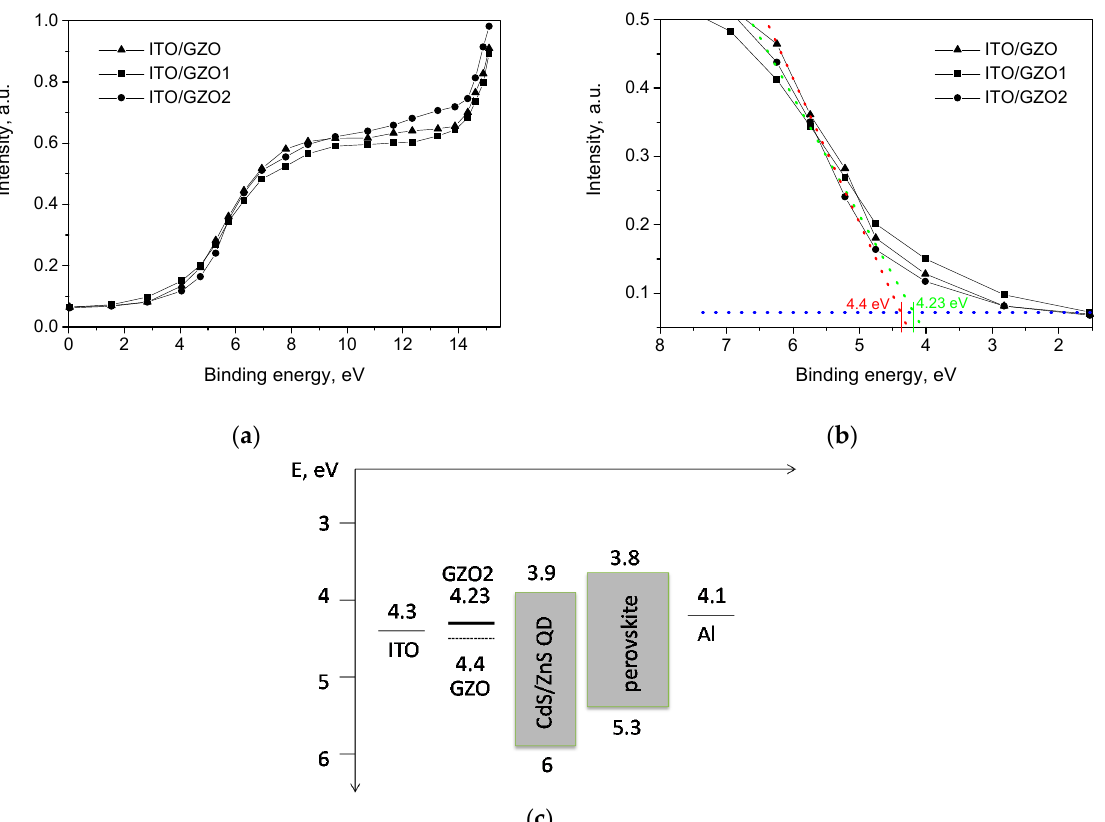
Figure 6. Work function of the ITO/GZO films at various oxidation degrees: ( a ) UPS spectra for determination of the work function of ITO/GZO at different oxidation degree; ( b ) zoomed UPS spectrums ( c ) energy band diagram of CdS/ZnS core-shell quantum dots/perovskite solar cell with optimal ITO/GZO2 film as TCE.